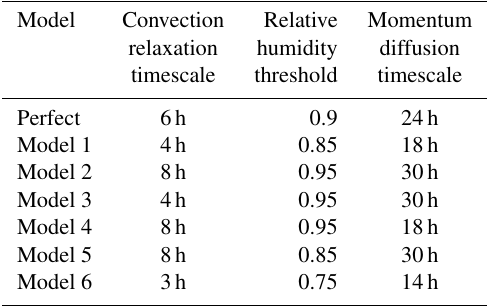
Table 1. Parameter values of perfect and imperfect